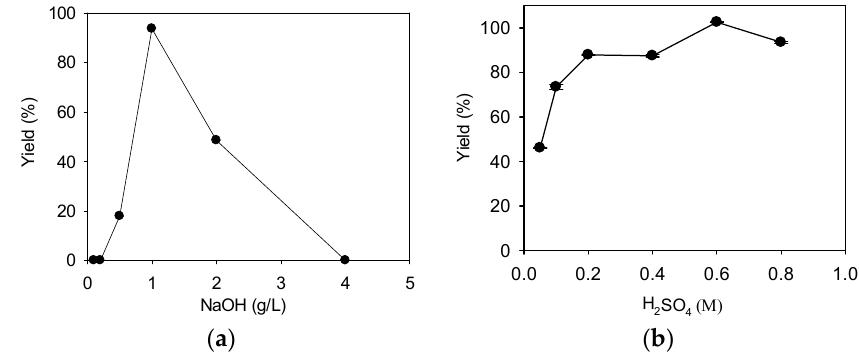
Figure 1. The effect of catalyst concentration on fatty acid methyl ester (FAME) yield. ( a ) NaOH; ( b ) H 2 SO 4 . For both catalysts, direct transesterification on 1 g of dry R. glutinis biomass was carried out with a methanol loading of 1:20 (biomass: methanol, w / v ) at 70 °C for 15 h. Data were obtained by averaging three individual measurements and the standard deviations were indicated with error bars.